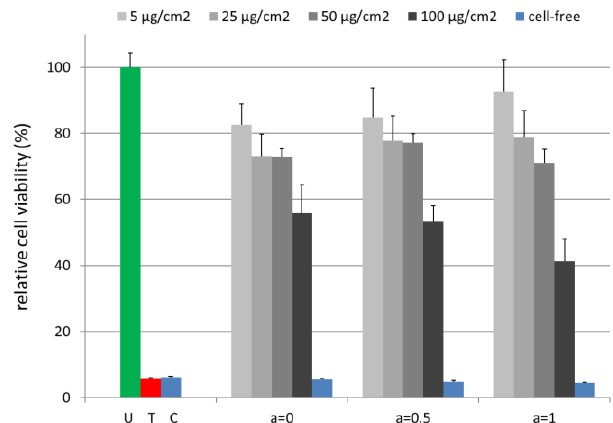
Figure 9. Magnetic nanoparticles (MNPs) with varying Co contents have a minor effect on the cell viability up to a concentration of 50 µg/cm 2 . The PrestoBlue Cell Viability Reagent was added after a 24 h incubation of the HBMEC samples. Cell-free samples contain 100 µg/cm 2 MNPs. The 0.1% ( v/v ) Triton X 100 serves as a toxic control (T). U: untreated HBMEC control; C: cell-free medium control. n = 4–8 technical replicates .